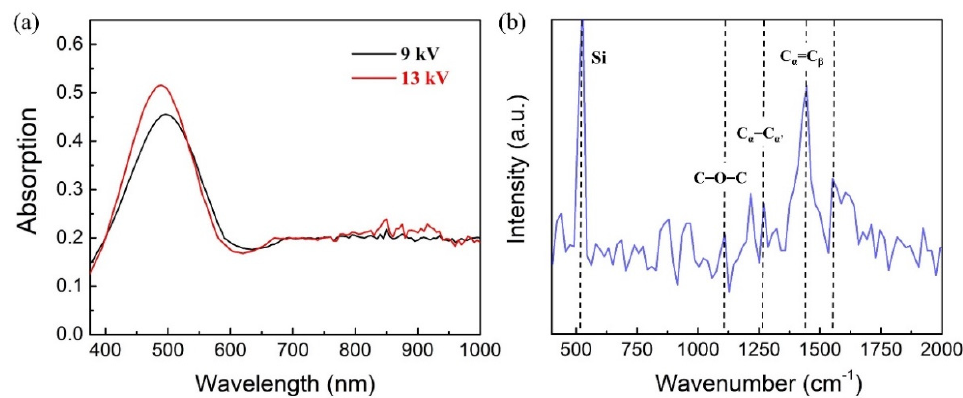
Figure 2. ( a ) the UV-Vis spectra of PEDOT:PSS electrospinning nanofibers deposited on the silicon wafer with spinning voltage at 9 kV and 13 kV; ( b ) the Raman spectrum of the PEDOT:PSS nanofibers deposited on the silicon wafer with 13 kV spinning voltage, the 520 cm − 1 peak is the characterize peak of the silicon.